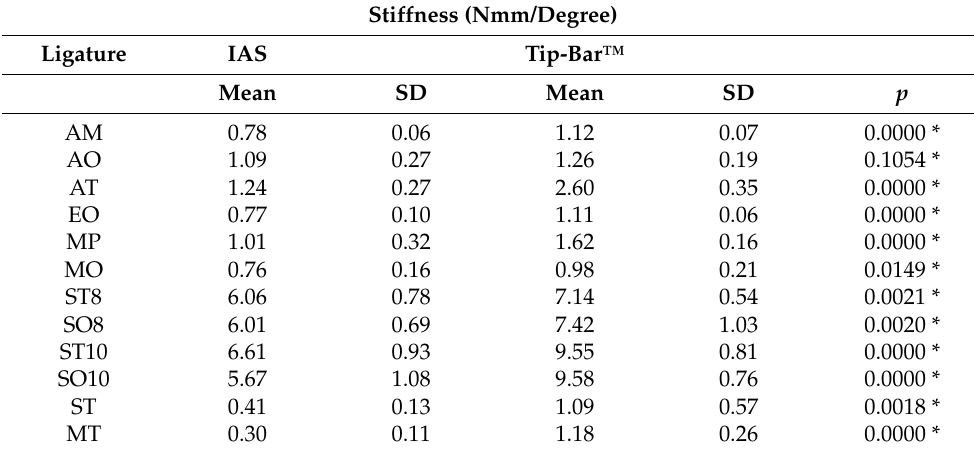
Table 2. Overview of the stiffness (mean and SD) of the various ligature types and bracket combina- tions. The p values (*) refer to a comparison between the IAS and Tip-Bar™ brackets.